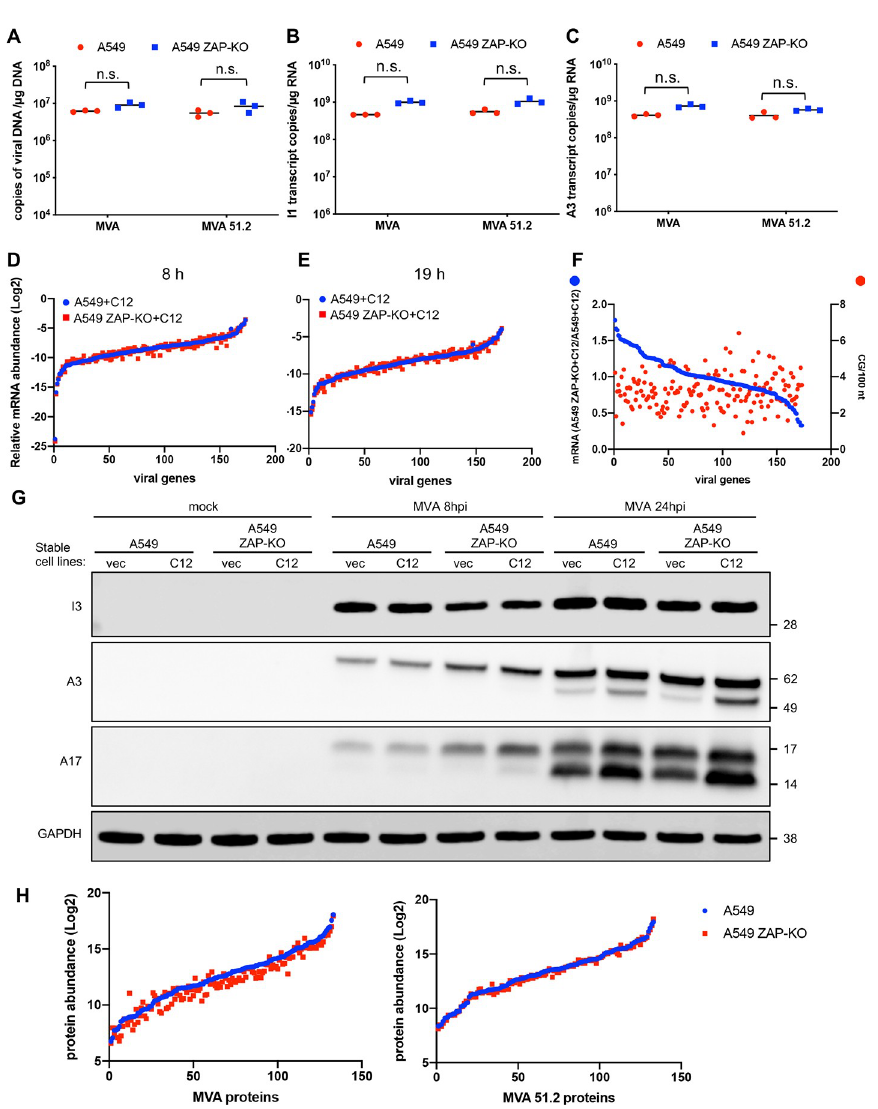
Fig 5. Effect of ZAP on MVA genome replication and gene expression. (A) A549 and A549 ZAP-KO cells were infected in triplicate with 5 PFU/cell of MVA or MVA 51.2. After 6 h, DNA was isolated and genome copies determined by ddPCR. DNA copies from each sample are shown as dots, and the bar represents the mean value. n.s., not significant, p > 0.05. (B, C) A549 and A549 ZAP-KO cells were infected in triplicate with MVA or MVA 51.2 for 8 h. RNA was extracted, poly(A) selected, and cDNA prepared. Copy numbers of I1 and A3 transcripts per μ g of RNA were determined with specific primers using ddPCR and shown as dots; the bar represents the mean value. ( D, E ) A549+C12 and A549 ZAP-KO+C12 cells were infected in triplicate as in above panels and RNA read counts at 8 and 19 h determined by RNAseq. Abundances of individual viral RNAs were plotted after normalization to total read counts in each sample. ( F ) Ratios of individual MVA mRNAs from A549 ZAP-KO+C12 cells/A549+C12 cells at 8 h after infection and CpG densities of individual mRNAs were plotted. ( G ) Expression and processing of viral proteins. A549, A549 ZAP-KO cells stably transfected with C12 or an empty vector (vec) were mock infected or infected with MVA at 5 PFU/cell. Total proteins were collected after 8 or 24 h and resolved by SDS-PAGE. Viral early I3, intermediate/late A3 virion core and A17 virion membrane proteins and GAPDH loading control were resolved by SDS-PAGE and detected by probing Western blots with specific antibodies. ( H ) Abundances of individual viral proteins from A549 and A549 ZAP-KO cells infected with MVA or MVA 51.2 for 18 h determined by TMT mass spectrometry.